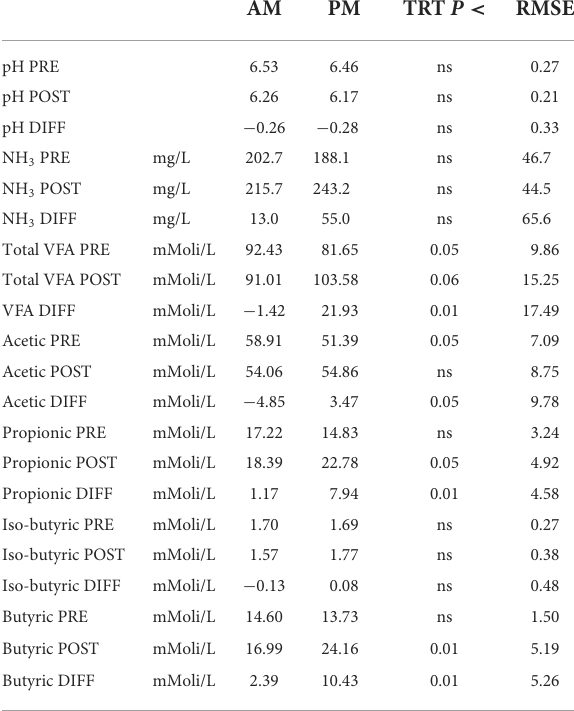
TABLE 2 Effect of the timing of pasture allocation on rumen liquor components pre- (PRE) and post (POST) grazing and their changes (DIFF = POST-PRE) during the grazing sessions on day 39 (week